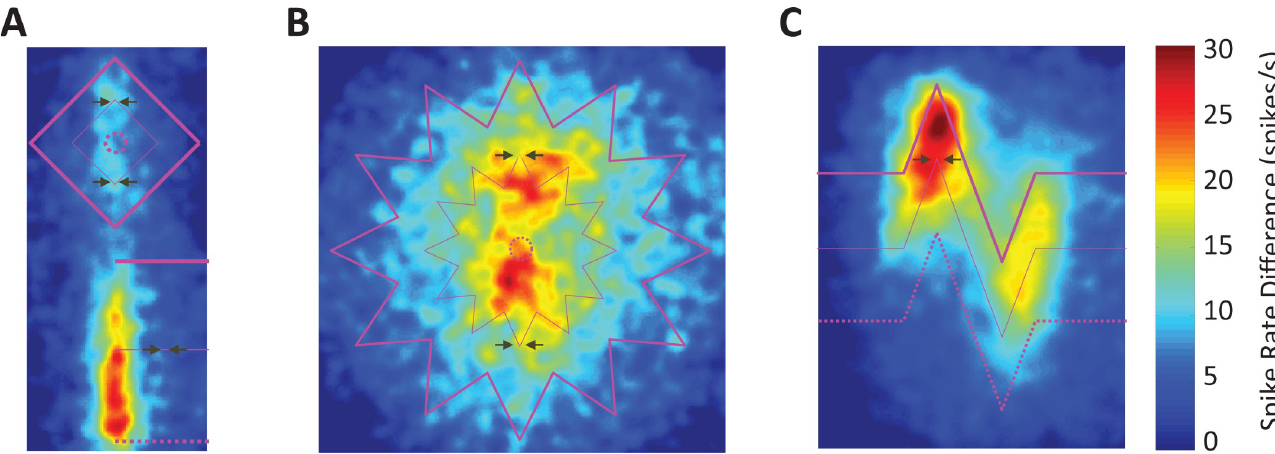
Fig 5. Average spike rate difference maps. The average spike rate differences at each DU in the respective ROIs are shown for (A) Square and Edge ( N = 25), (B) Star ( N = 30), and (C) Corners ( N = 28). The vertical corner-folds are aligned with the preferred orientation of the neurons. The thick, thin, and dashed purple lines indicate the 0%, 50%, and 100% equal luminance lines. Note that in Star and in Square, the 100% equal luminance line contracts to a single point at the center and so we use a small dotted circle to represent this. The paired arrows indicate the midpoints (50% luminance) of corner-folds (i.e. P180˚, S90˚, S52˚ and S40˚) where midpoint responses were calculated.